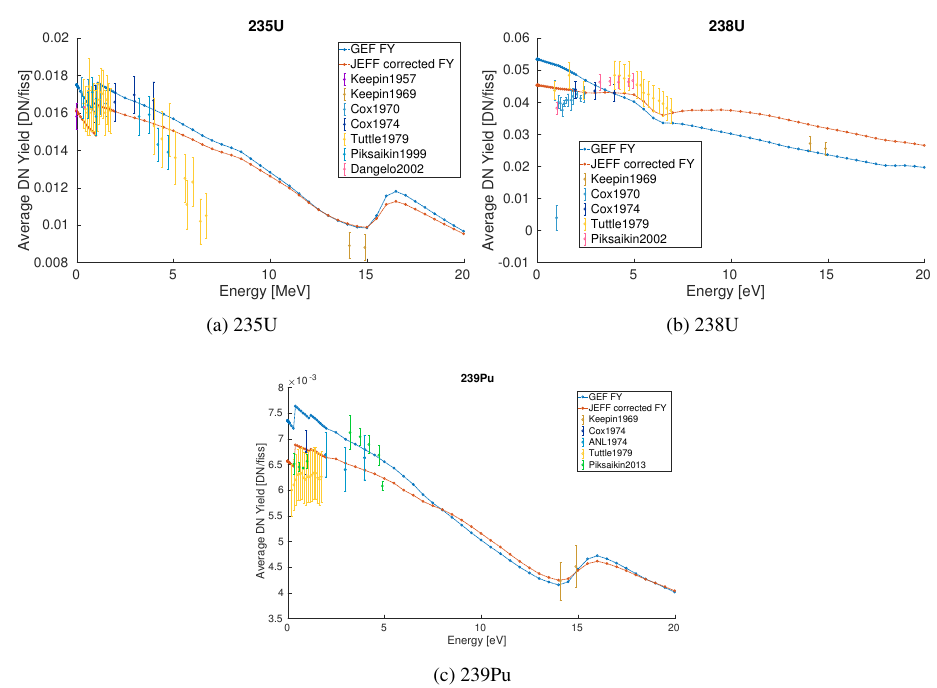
Figure 2: Energy dependence of average delayed neutron yield computed with GEF-6.1 FY and with JEFF-3.1.1 FY modified with GEF-6.1 energy dependence. Experimental values are reported for